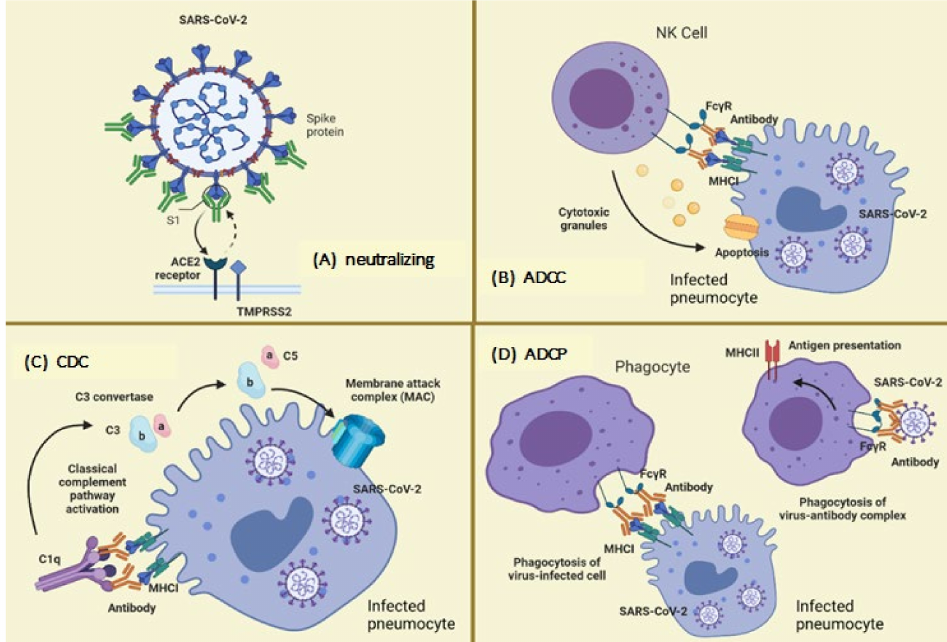
Figure 1. Neutralizing and non-neutralizing actions of antibodies. ( A ) The neutralizing action is carried out through the variable fraction (Fab) of the antibody, whose primary limitation is viral resistance. Here, effector mechanisms enter to avoid viral replication. For example, in the ADCC mechanism ( B ), Fc gamma receptors present in some cells (e.g., natural killers cells, NK) engage with antibody-bound infected cells and induce target cell death through the release of cytotoxic granules; in the CDC mechanism ( C ), binding of C1q to antibody-bound virus-infected cells leads to the activation of the classical complement pathway, or the ADCP mechanism ( D ), phagocytes can clear virus-infected cells and immune complexes that are engaged by Fc gamma receptors through phagocytosis. Abbreviations: ADCC, antibody-dependent cell cytotoxicity; CDC antibody-mediated complement-dependent cytotoxicity; ADCP, antibody-dependent cellular phagocytosis; ACE2, angiotensin-converting enzyme 2; TMPRSS2, transmembrane serine protease